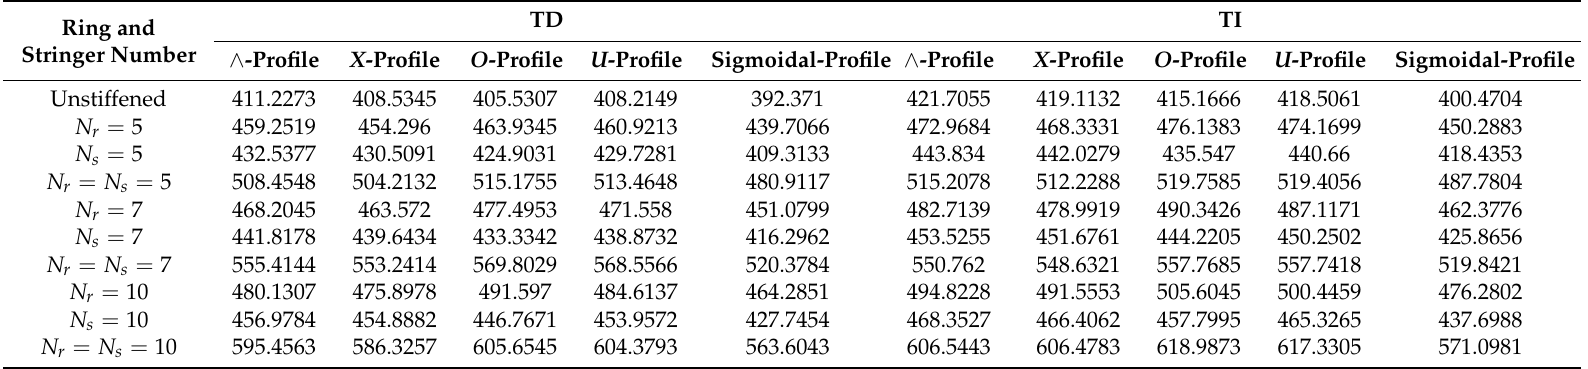
Table 5. Effect of the stiffeners on the critical thermal buckling load of the cylindrical shell reinforced by wavy graded CNTs for different profiles considering L / R =